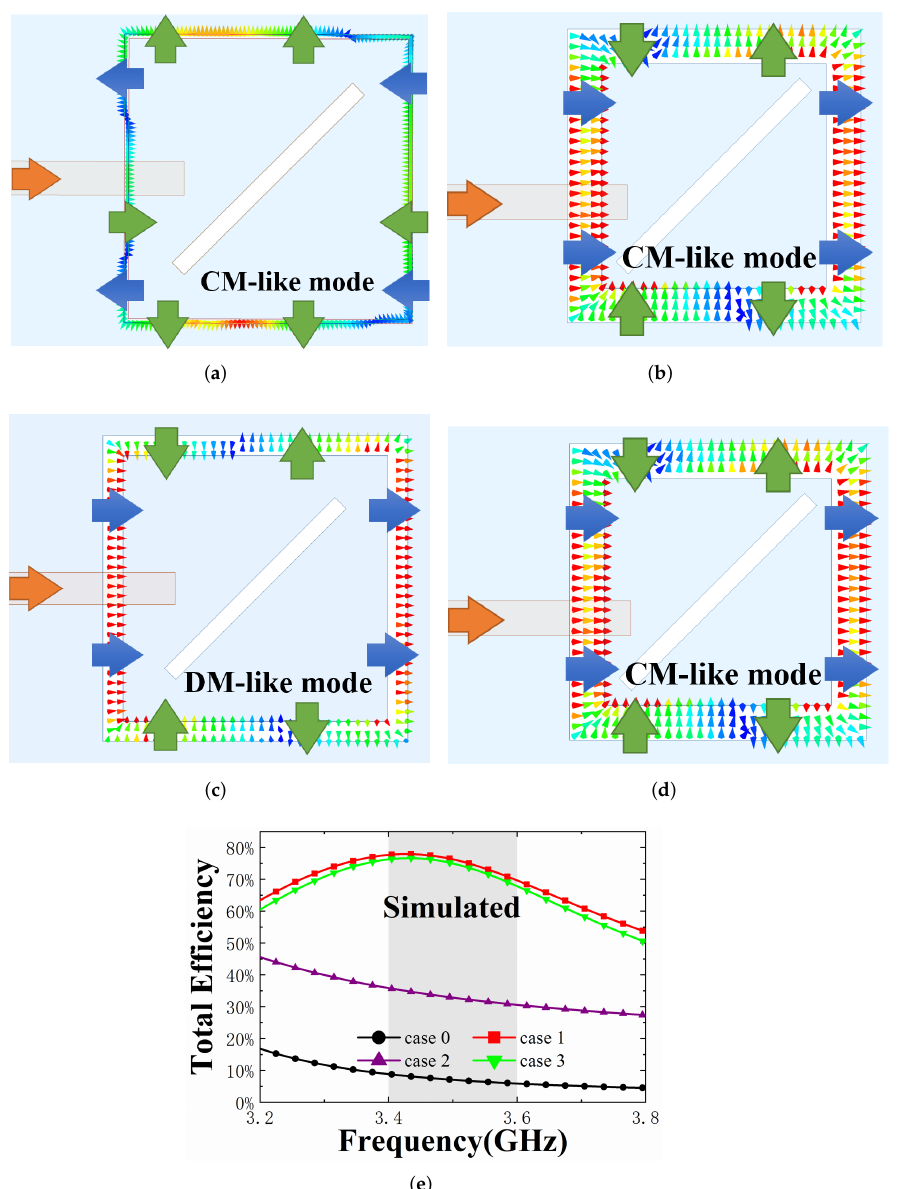
Figure 7. Electric field distribution of the proposed antenna at ( a ) case 0. ( b ) case 1. ( c ) case 2.( d ) case 3. ( e )